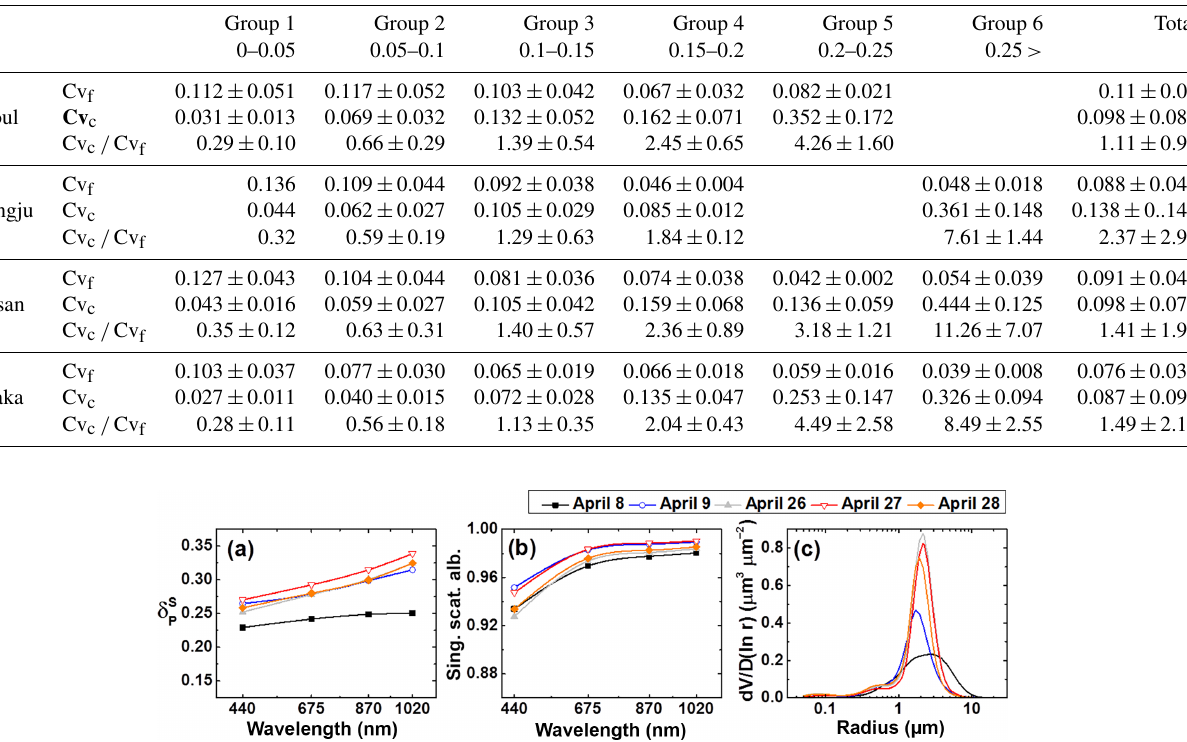
Table 2. Averaged volume concentration of the fine (Cv f ) and the coarse (Cv c ) modes and the ratio (Cv c / Cv f ) for the six groups.